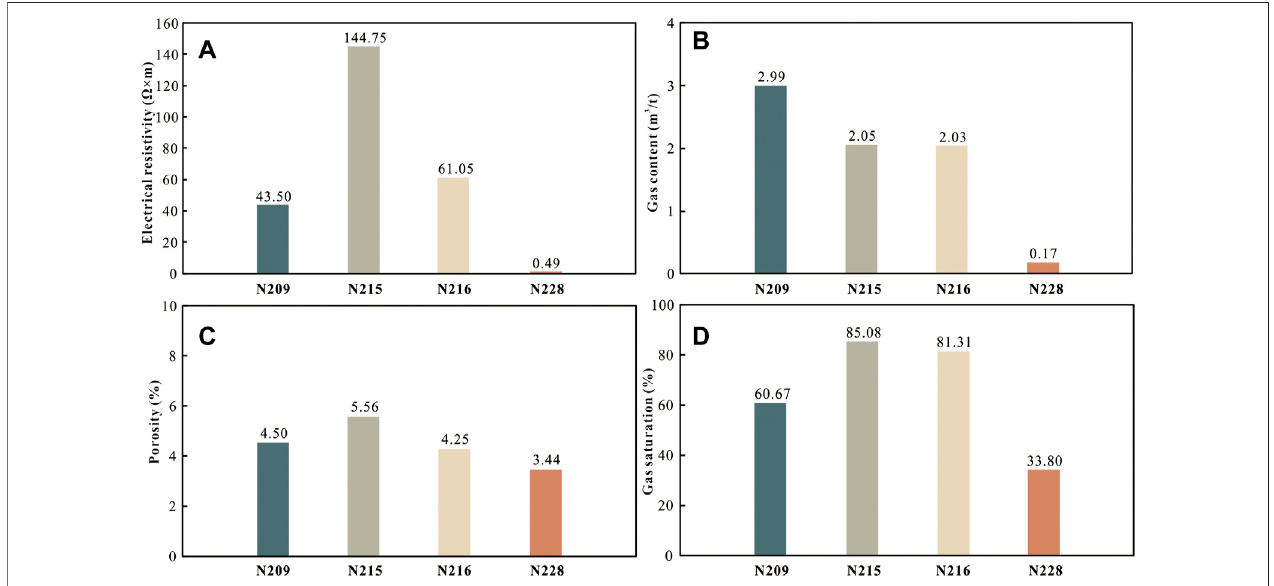
FIGURE 13 | (A) Resistivity, (B) gas content, (C) porosity, and (D) gas saturation of wells N228, N216, N209, and N215.